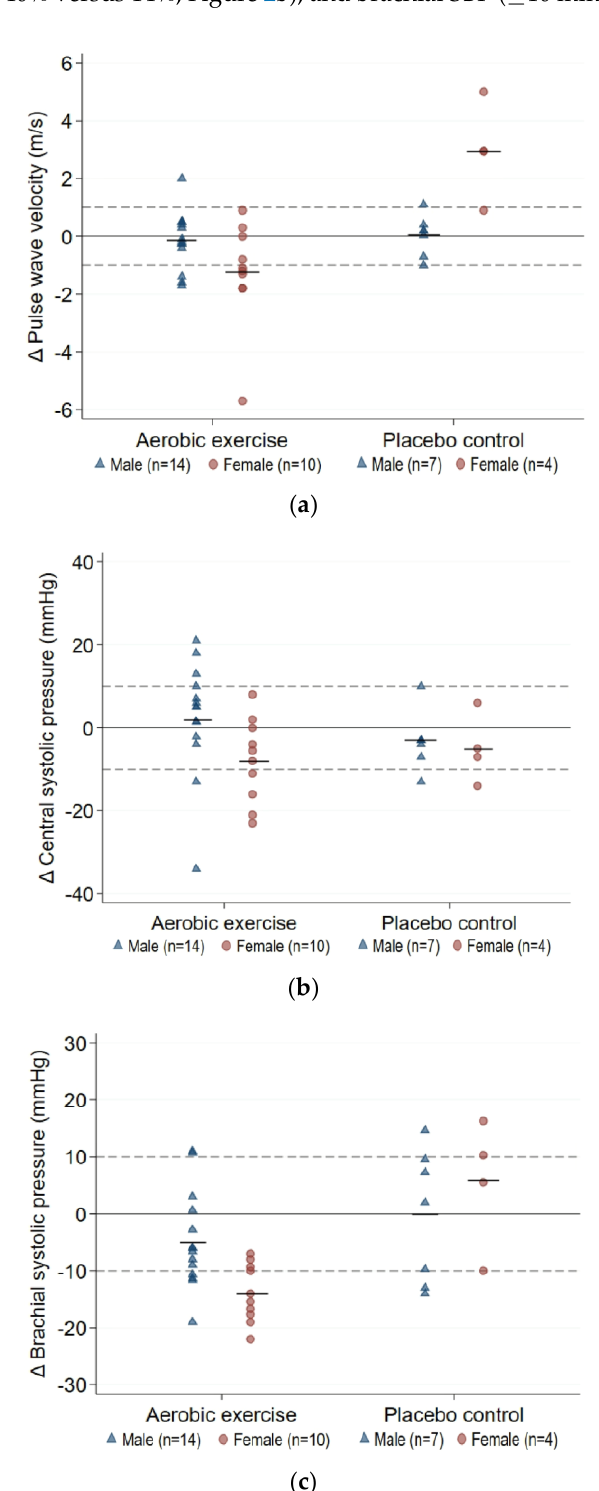
Figure 2. Individual 12-week changes in arterial health outcomes: ( a ) pulse wave velocity; ( b ) central systolic pressure; ( c ) brachial systolic pressure. Solid reference line: mean change from baseline; dashed reference line: minimal clinically important difference.